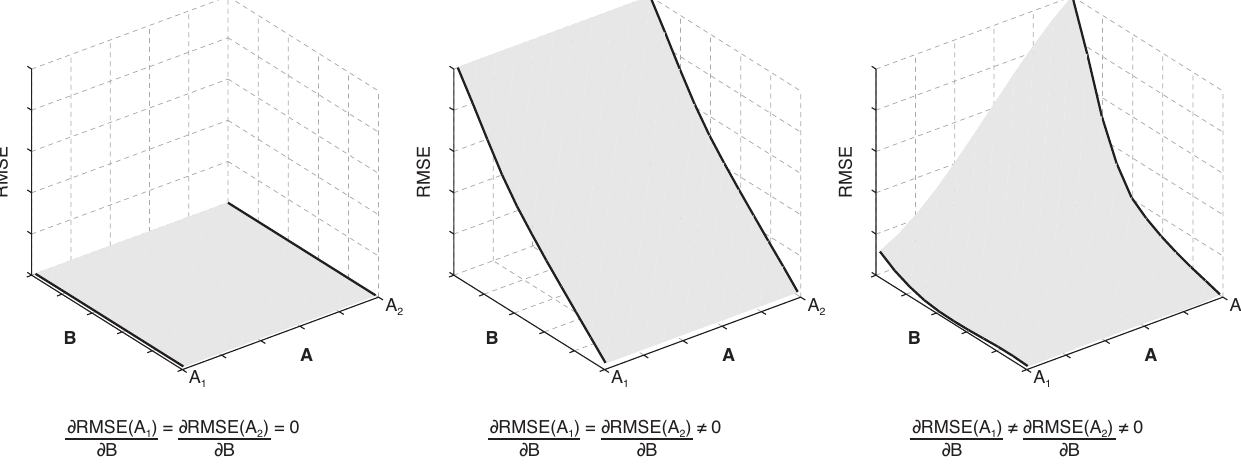
Fig. 1. Examples for inter-parameter dependencies. From left to right: (1) both parameters insensitive, (2) both parameters sensitive with linear dependency, (3) both parameters sensitive but non-linear dependency. Table 1. Estimated values for the flow model derived from the model calibration and value ranges reported in the literature. Subscript m and c denote the matrix resp. the conduit